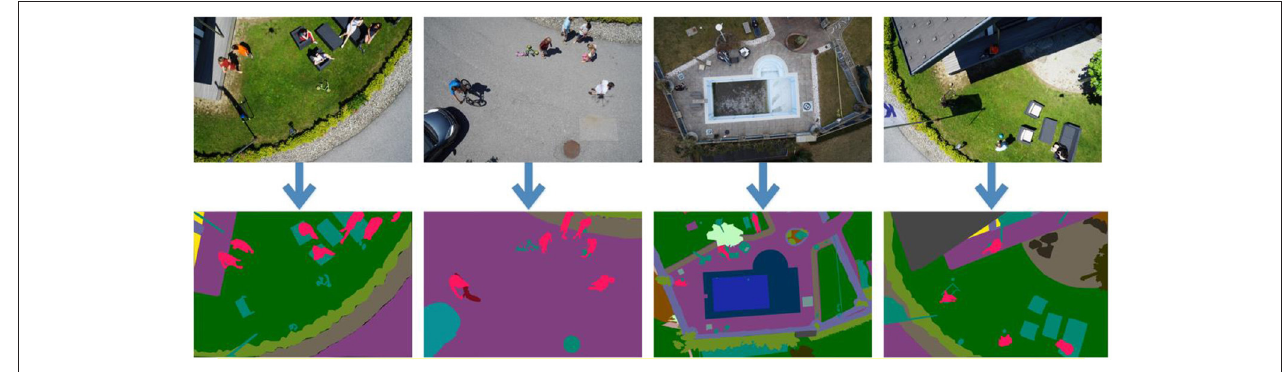
FIGURE 1 | Sample Semantic Drone Dataset images and corresponding semantic masks (Different classes in each image are marked with different colors)